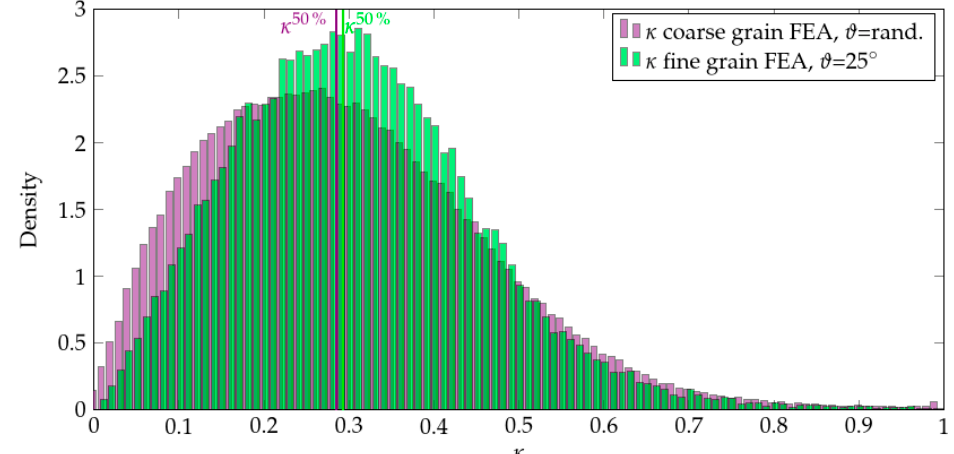
Figure 9. Frequency distribution of the parameter κ to evaluate the stress state on every simulated node of both specimen models.